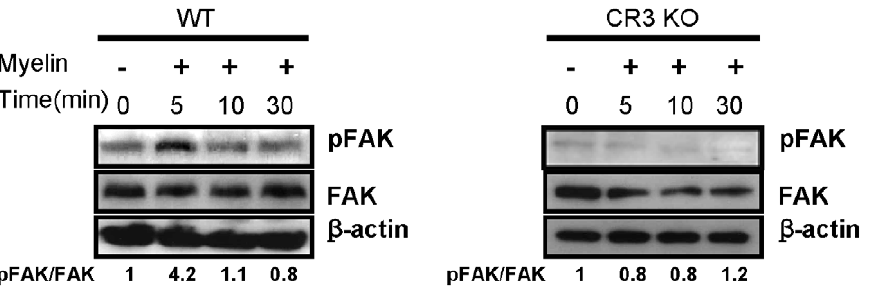
Figure 7. Effect of myelin on FAK phosphorylation. Bone marrow-derived macrophages from WT and CR3 KO mice were treated with myelin for the indicated time and phosphorylation of FAK (pFAK) was assessed by western blot. Phosphorylation levels were normalized to non- phosphorylated total proteins. Similar results were obtained from three independent experiments.